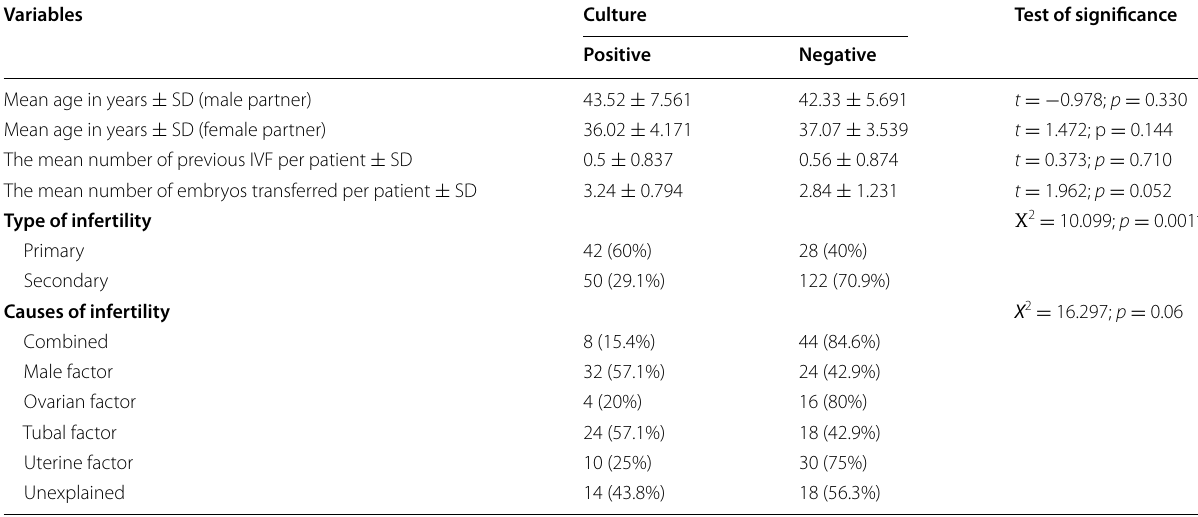
Table 1 The clinical characteristics of the study participants